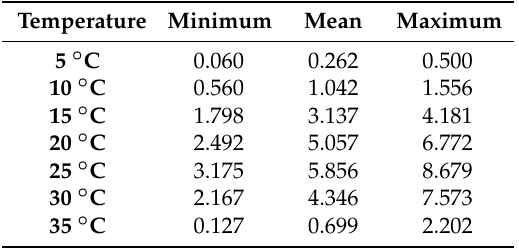
Table 1. The minimum, mean and maximum daily growth rates (mm per day) of the F. circinatum isolates ( n = 162) used in this study.